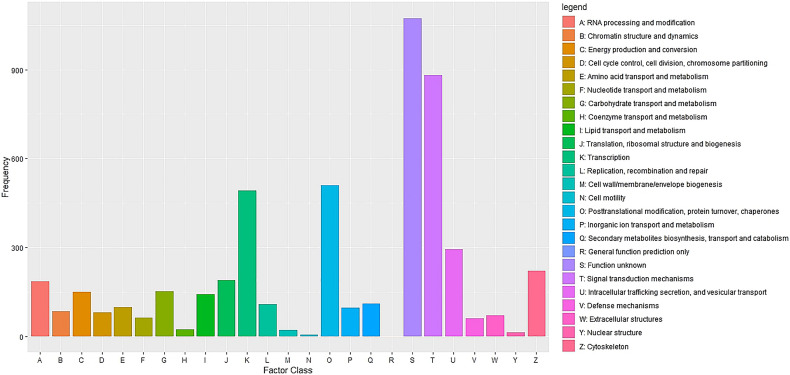
Functional classification of the pacu liver transcriptome exposed to A. hydrophila infection based on eggnog/COG orthologous groups (E-value < 1e-3). 4,931 pacu transcripts were classified in 25 functional categories arranged in the x-axis. The y-axis presents the frequency of each represented category.